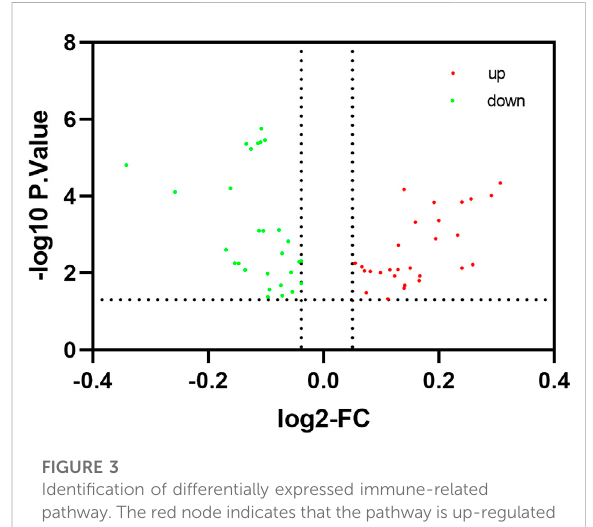
FIGURE 3 Identi fi cation of differentially expressed immune-related pathway. The red node indicates that the pathway is up-regulated inthetreatment groupoftheblood, Thegreennode indicatesthat the pathway is up-regulated in the control group of the